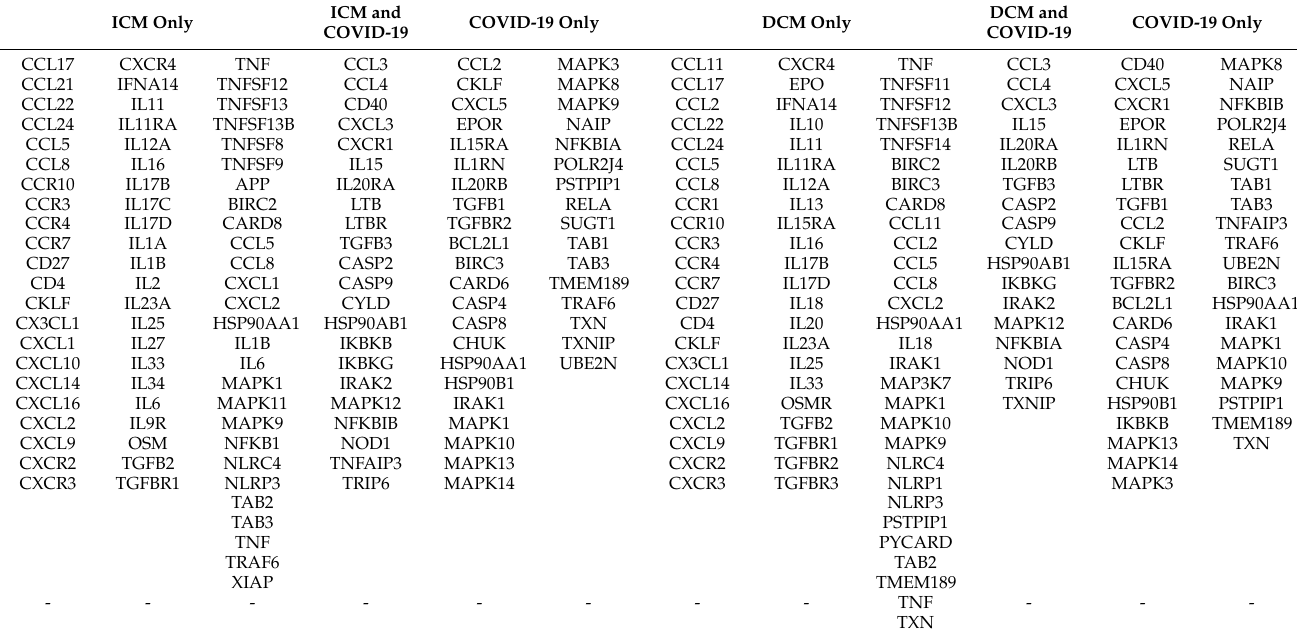
Table A1. Complete list of dysregulated cytokine and inflammasome-related genes.